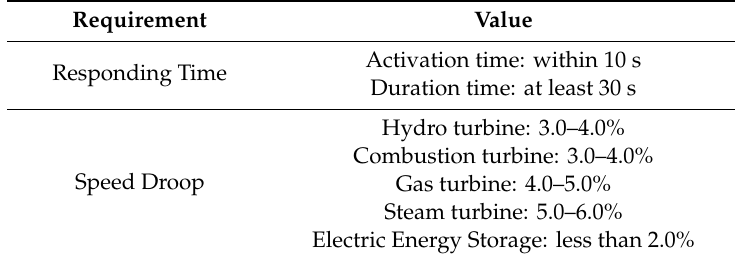
Table 2. Requirements for primary frequency control in the Korean power